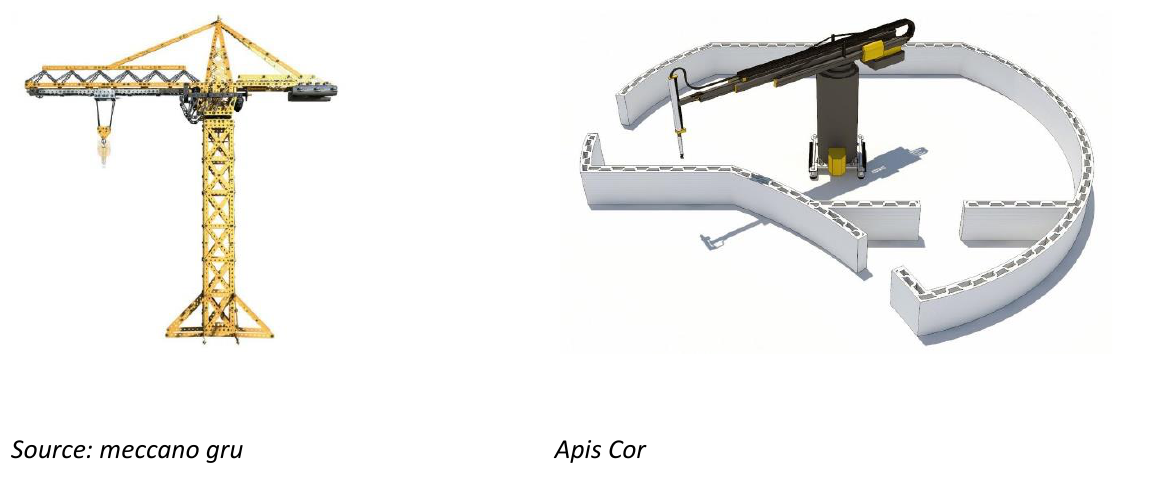
Figure 3: Construction crane vs Robotic Arm system